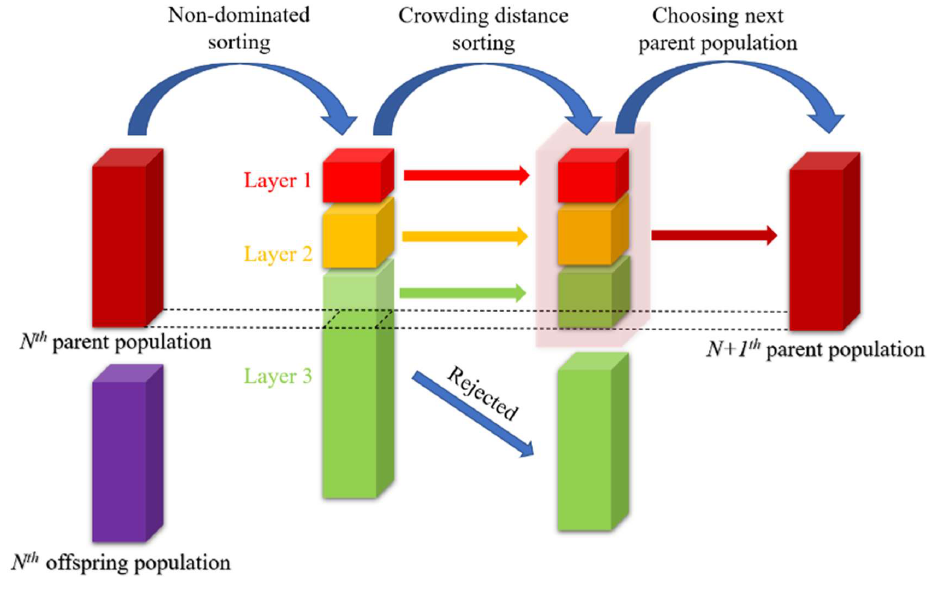
Figure 2. Procedure of NSGA-II.